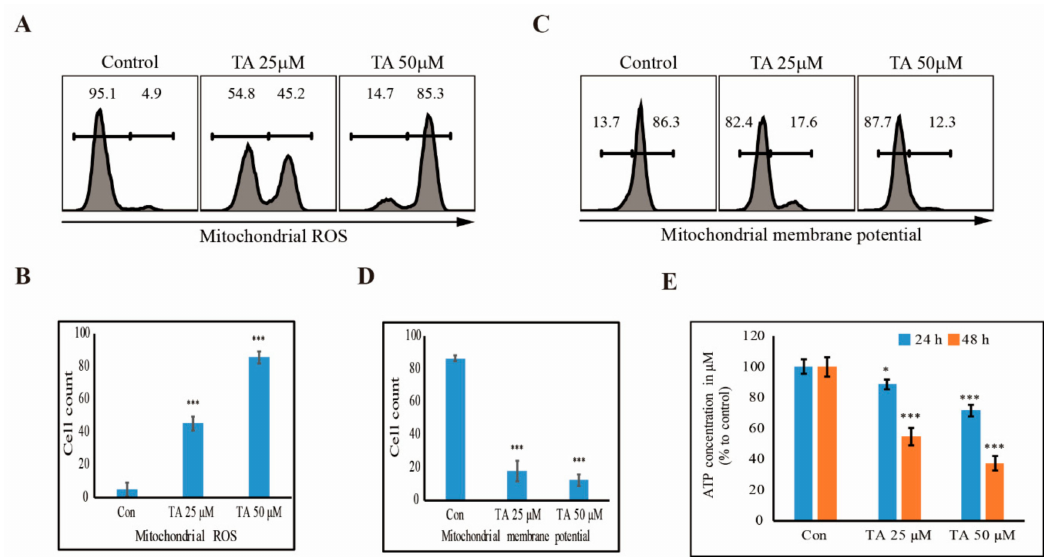
Figure 5. TA induces mROS and inhibits ATP production in NCCIT cells. ( A ) Flow cytometry analysis showing mROS after treatment with 25 µ M and 50 µ M TA for 48 h in NCCIT cells. ( B ) Graphical representation of mROS production with TA treatment. *** p < 0.001 ( t -test). ( C ) Flow cytometry analysis showing mitochondrial membrane potential after treatment with 25 µ M and 50 µ M TA for 48 h in NCCIT cells. ( D ) Graphical representation of mitochondrial membrane potential with TA treatment. *** p < 0.001 ( t -test). ( E ) ATP determination assay showing ATP production in NCCIT cells after treatment with 25 µ M and 50 µ M TA for 24 h and 48 h. Controls are set to 100. * p < 0.05 and *** p < 0.001 ( t